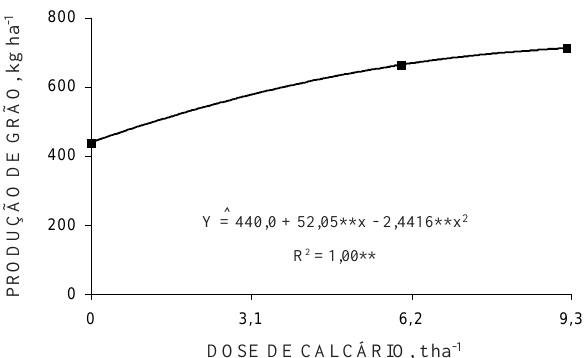
Figura 2. Efeito da aplicação de calcário na produção de grãos da aveia preta. Significativo a 1%. (Média para todas as doses de